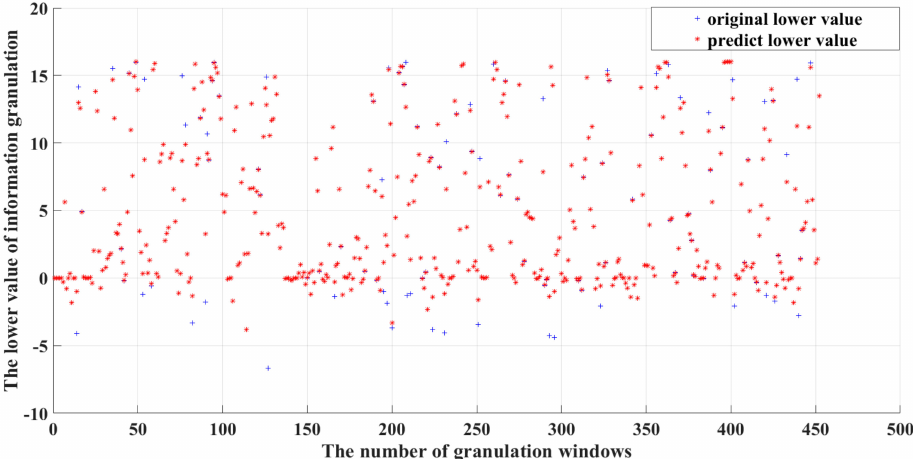
Figure 8. The prediction effect of the lower